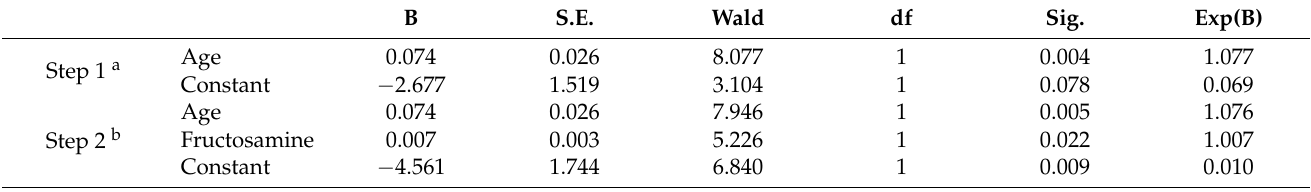
Table 5. Factors associated with the development of this composite endpoint-1 (significant periop- erative complications + extended hospital stay after surgery) after CABG (binary logistic regression analysis, forward LR method).